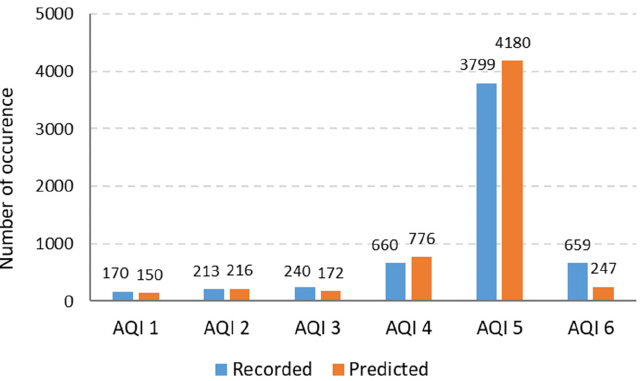
Figure 11. Comparison of AQI classes set on the base of hourly concentration of PM 2.5 recorded by the system and predicted using a model for traffic and meteorological data considered in the validation set.